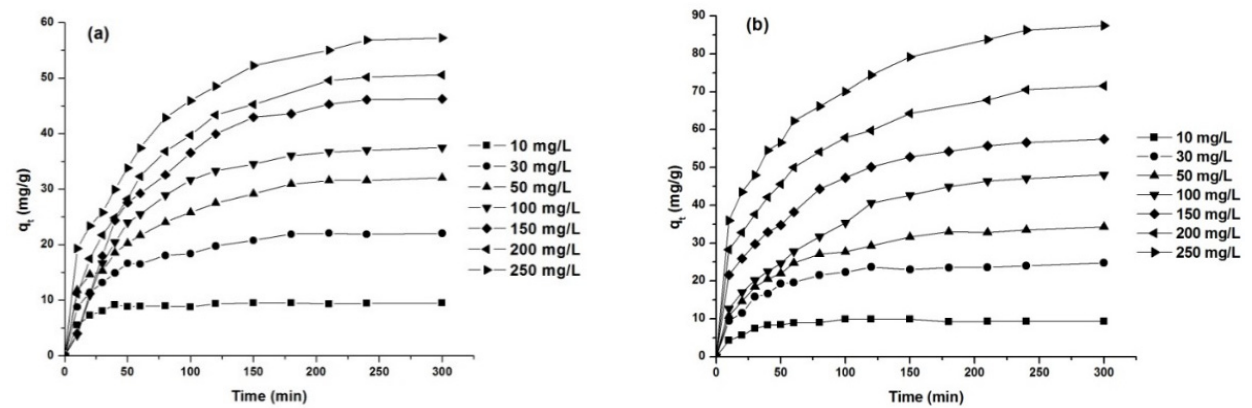
Figure 10. Effect of initial concentration on dye removal capacity: AY 42 ( a ) and AR 213 ( b ); 1 g/L PM4, 25 °C, natural pH of solution. Table 6. Influence of the initial concentration of dye solutions on the adsorption capacity of PM4.